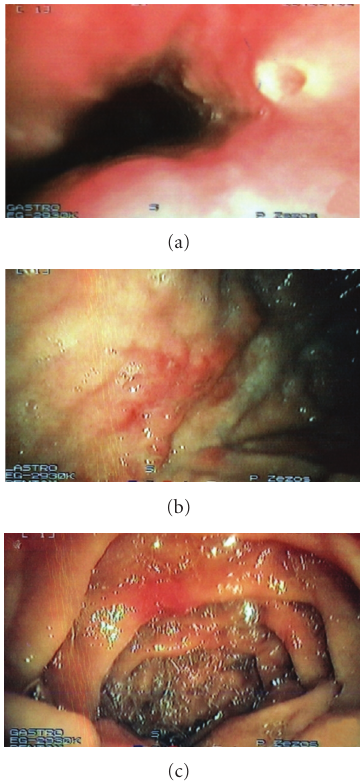
Figure 2: Upper gastrointestinal endoscopy revealed proximal Crohn’s disease with erosions in esophagus (a), stomach (b) and duodenum (c).